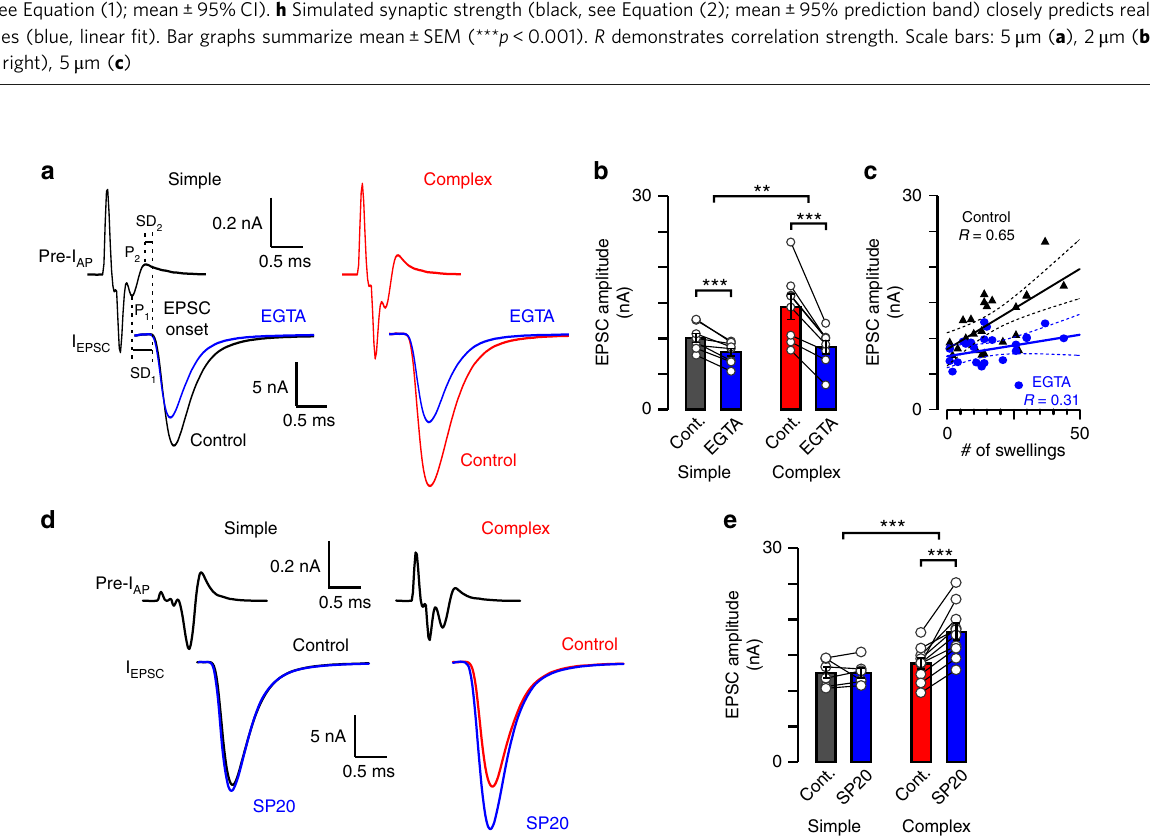
Fig. 4 Topography of VGCC clusters is different in swellings and stalks. a Z -axis projection images visualize citrine-tagged Cav2.1 α 1 subunits ( Cacna1a Citrine , green) and calyces (Alexa594 dextran, A594d; red). Calyx highlighted with white dashed rectangle is shown in b and d . b Calyx top view ( z -axis projection, 7 optical sections) shows punctate citrine labeling (Sw, swelling, St, stalk). Areas in gray dashed rectangles are enlarged on the right. Pro fi le line and plot demonstrate separation of puncta (Sw, red; St, black). Thresholds (black arrows) identify clusters. c Calyx cross-section shows clusters along the presynaptic face (white arrows). d The number of clusters per calyx versus calyx complexity plot was fi tted linearly ( y -axis intercept: number of clusters on stalk, 431.9 ± 79.7; slope: number of clusters per swelling, 10.36 ± 3.8; mean ± 95% con fi dence interval [CI]). Bar graphs summarize the cluster number per calyx (simple, 509.4 ± 31.1, n = 10/7, complex, 708.8 ± 27.0, n = 14/4, t = 4.821, p < 0.0001, df = 22; unpaired t -test). e The cluster number per contact area was quanti fi ed in swellings and stalks (Sw, 2.12 ± 0.070 μ m − 2 , n = 25/4, St, 1.51 ± 0.057 μ m − 2 , n = 25/4, t = 7.680, p < 0.0001, df = 24; paired t -test). f Cumulative fl uorescence intensity per cluster (correlate of VGCC number per cluster) is expressed as relative value (St/Sw, 1.347 ± 0.063, n = 25/4, t = 5.488, p < 0.0001, df = 24, one sample t -test). g , h Individual release probabilities (Pr) and EPSC1 amplitudes for all recorded synapses were dot- plotted (gray triangles). Note the identical scatter-plots in Fig. 1b. g Whole-calyx Pr plot was fi tted with the weighted mean of Pr-s of distinct active zones